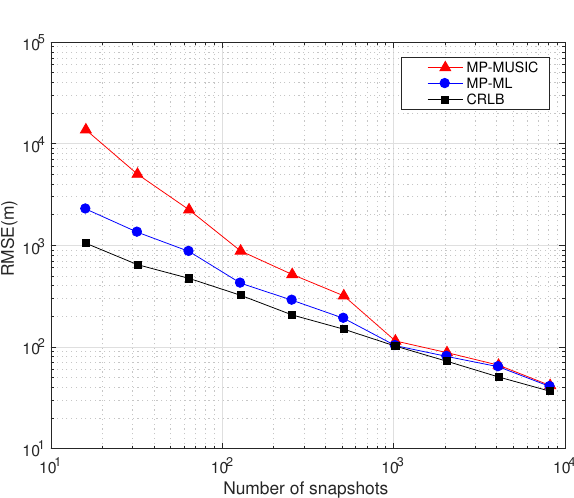
Figure 12. Performances of MP-MUSIC and MP-ML with different numbers of snapshots.